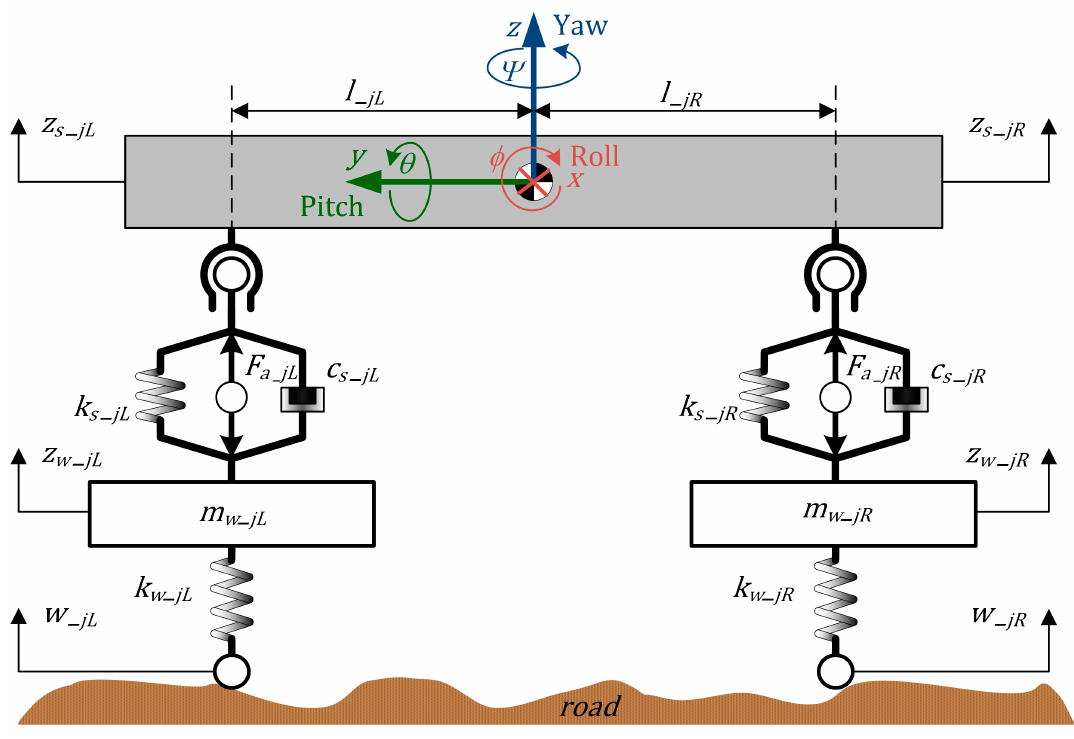
Figure 1. Half vehicle suspension model.